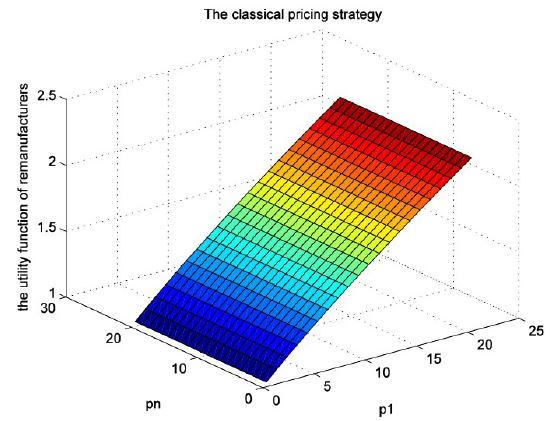
Figure 4. The classical remanufacturers’ pricing